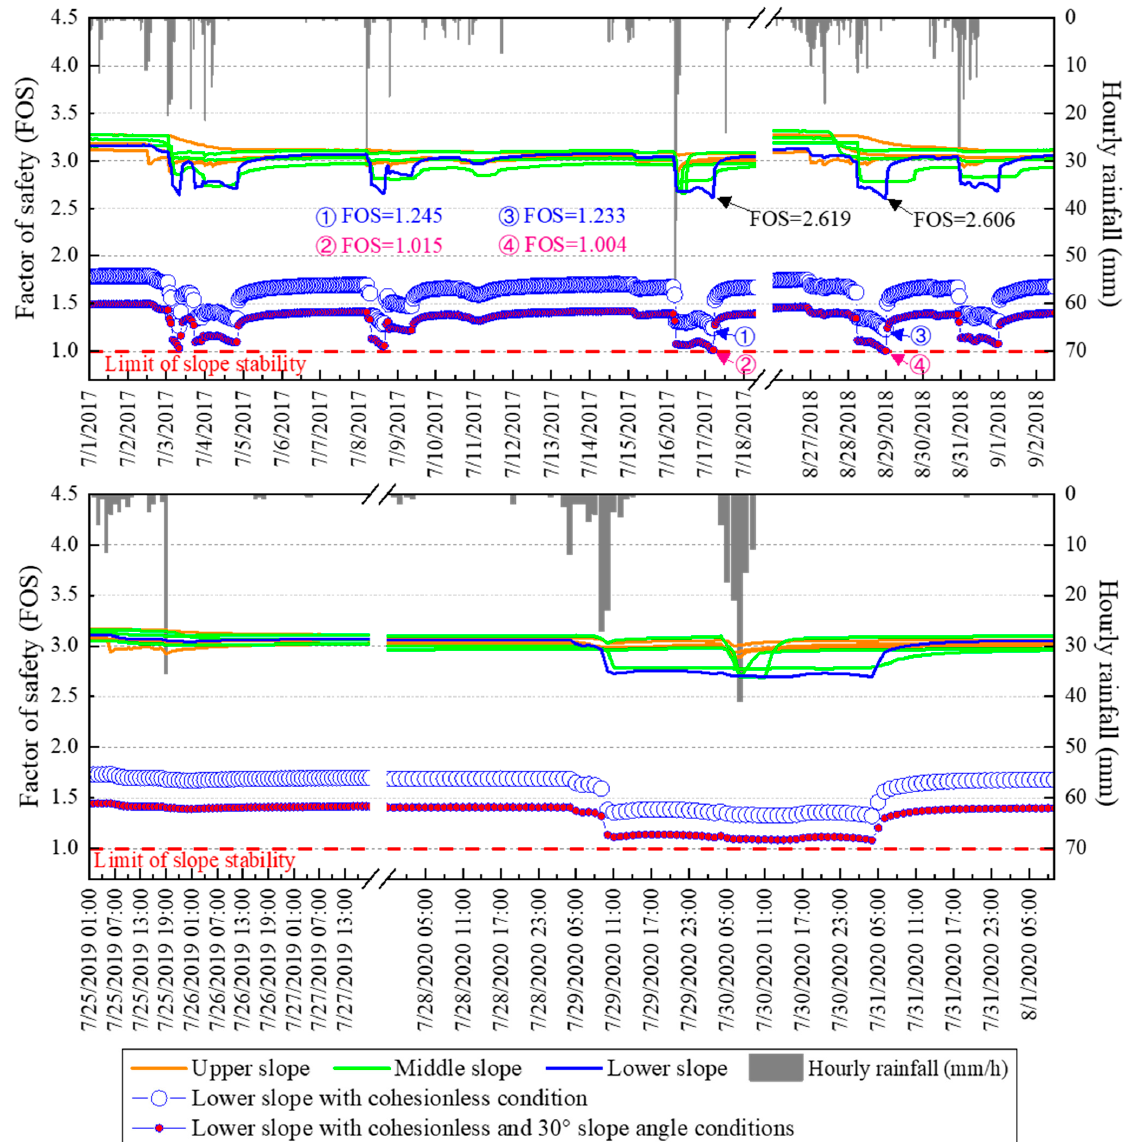
Figure 12. Hourly rainfalls and temporal variations in the factor of safety (FOS) values at 1.0 m under different slope conditions during annually representative rainfall events in the four-year study period.